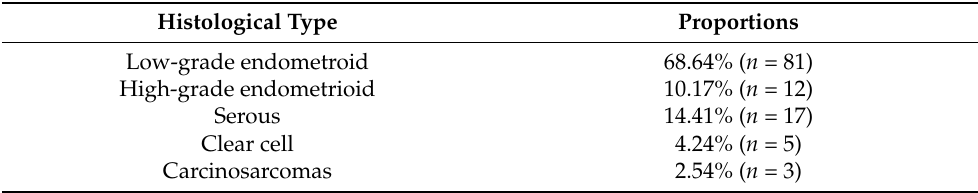
Table 2. Histological type distribution.